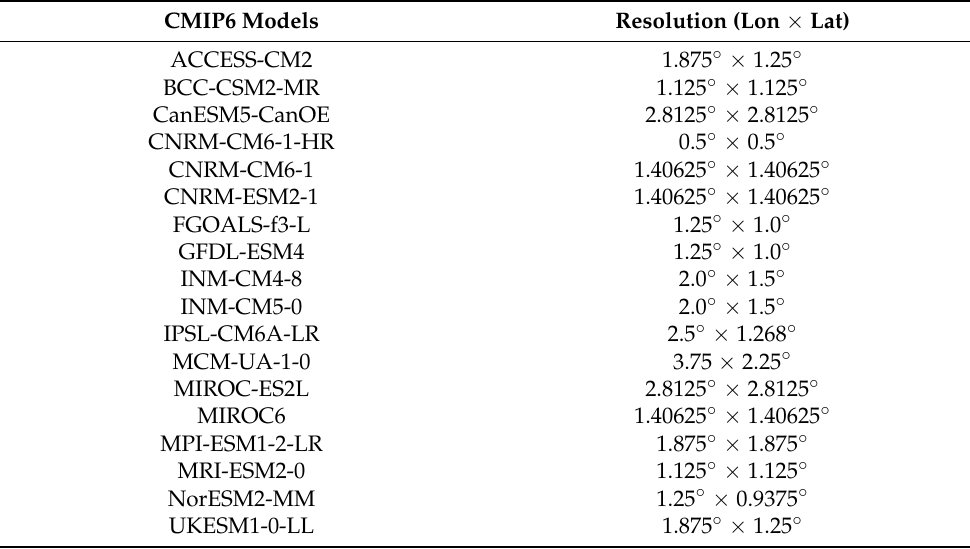
Table 2. Climate model outputs in the CMIP6 historical and SSP585 simulations that were used in the study. The spatial resolution of each model is also